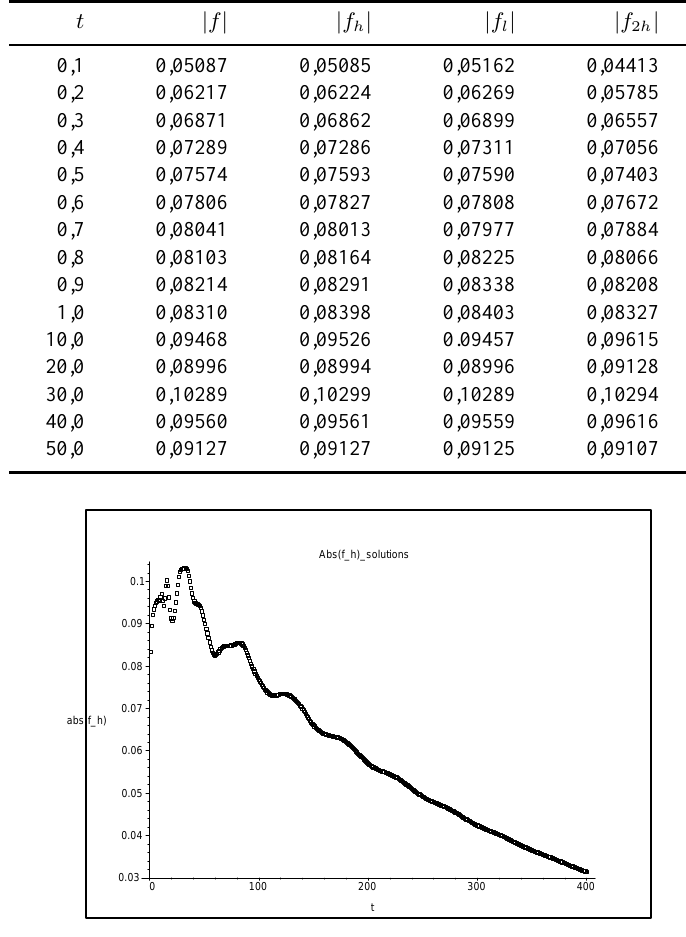
Table 3. The values j f j , j f h j , j f l j , j f 2 h j for x = L , (cid:28) = 0 ; 01 :